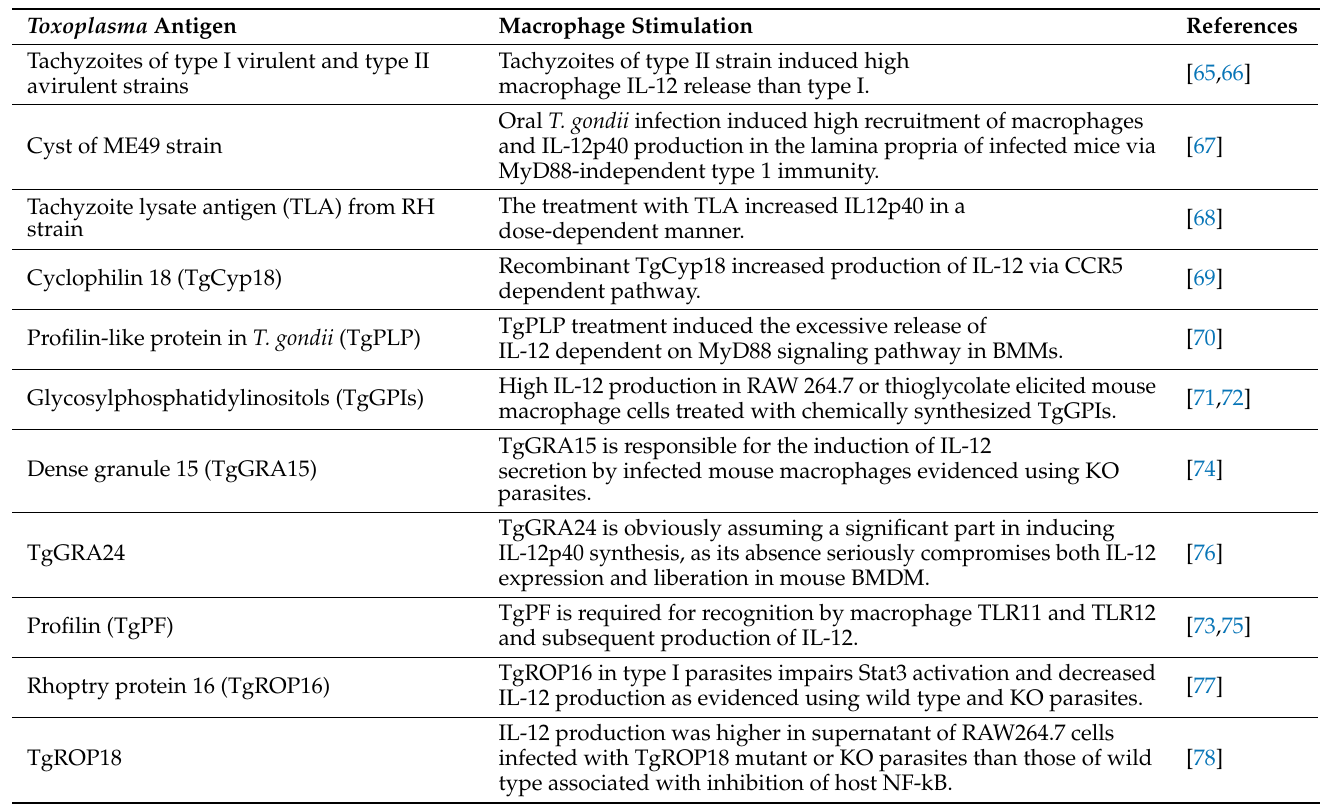
Table 1. A summary for previous studies assessed the effect of T. gondii or its derived molecules on macrophage production of